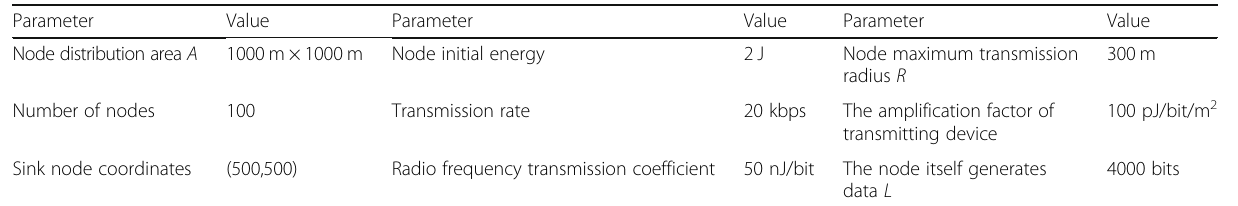
Table 1 Experimental parameters